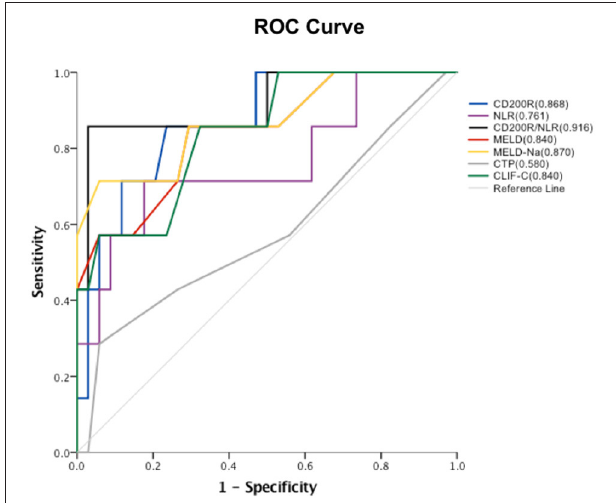
FIGURE 5 | ROC curve of each factor and areas under ROC curves. Proportions of baseline CD200R + CD4 + T cells, NLR, CD200R/NLR, MELD, MELD-Na, CTP and CLIF-C scores in predicting 90 d mortality in patients with HBV-ACLF.